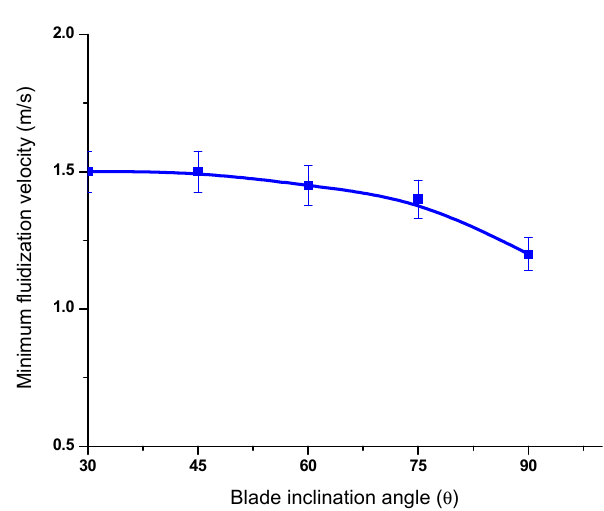
Figure 9. Minimum fluidization velocity versus blade inclination angle.